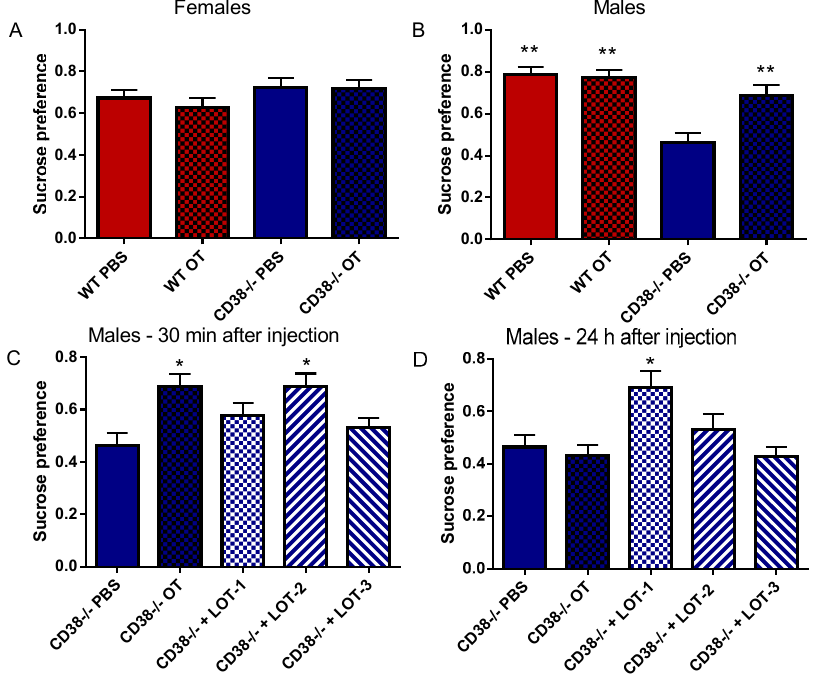
Figure 6. Sucrose preference test. The preference for 1% sucrose solution consumption by female ( A ) or male ( B ) CD38 +/+ (WT) and CD38 − / − mice 30 min after treatment with PBS or OT (single i.p. injection). One-way ANOVA was performed and revealed no significance for A ( F 3,40 = 0.559, p = 0.645) but significance for B ( F 3,30 = 12.91, p = 0.0001). ** p < 0.01 from CD38 − / − with PBS. Sucrose preference in males treated by PBS, OT, or the LOTs 30 min ( C ) or 24 h after injection ( D ). A one-way ANOVA followed by Bonferroni’s test revealed significance at 30 min after injection ( F 5,33 = 8.293, p = 0.0001) and 24 h after injection ( F 5,31 = 12.40, p = 0.0001). * indicates p < 0.05, ** indicates p < 0.01, compared with CD38 − / − male mice treated with PBS.